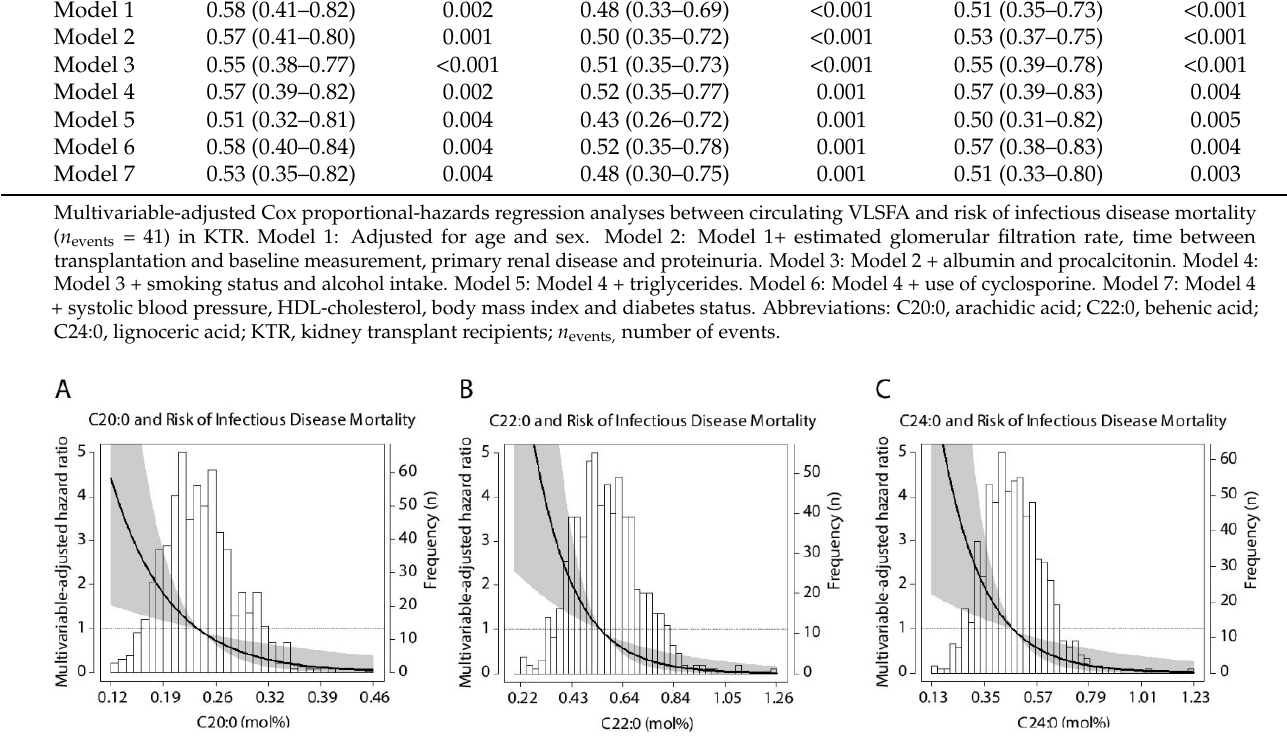
Figure 1. Association of standardized circulating VLSFA with risk of infectious disease mortality. Data were fitted by Cox proportional-hazards regression using mean C20:0 (0.24 mol%, A ), C22:0 (0.57 mol%, B ) and C24:0 (0.48 mol%, C ) concentrations as reference value. The black line represents the hazard ratio and the grey area represents the 95% confidence interval. Table 3. Prospective analysis of standardized circulating VLSFA with all-cause mortality in KTR. C20:0, per 1-SD Relative Increment Models